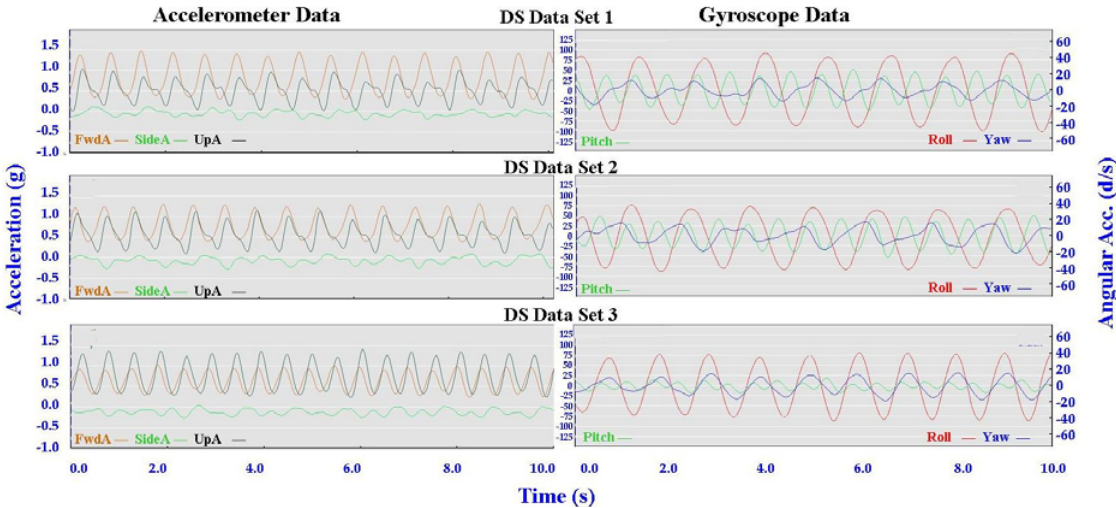
Figure 19. Longitudinal analysis of